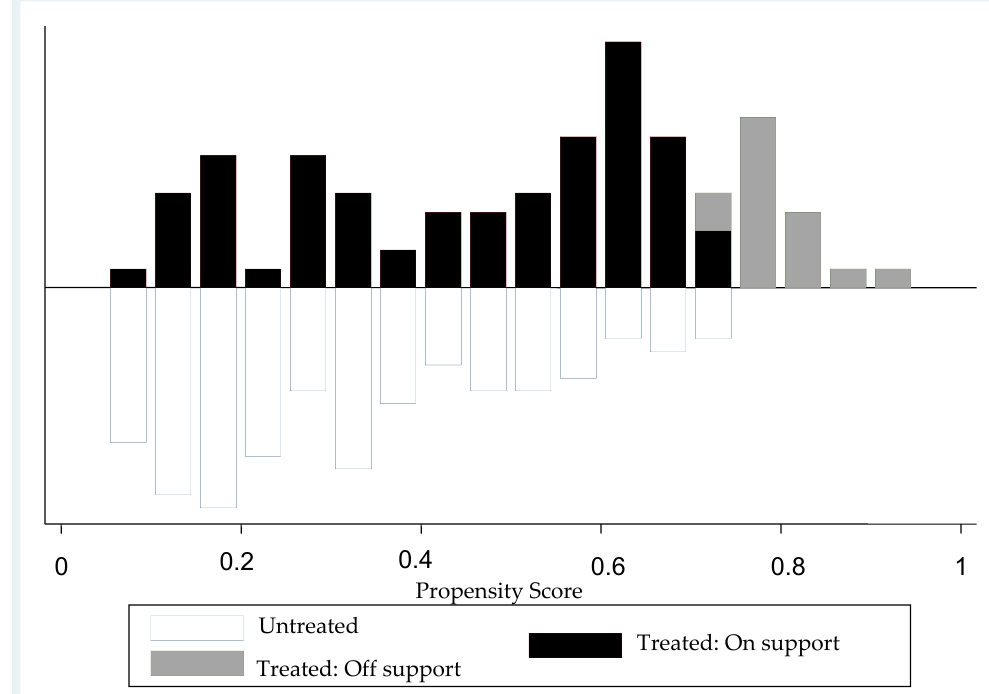
Figure 1. Histogram of estimated propensity score between participants (treated) and nonparticipants (untreated) of Farmers’ Training Center-based modular training. Source: Own elaboration with survey data.